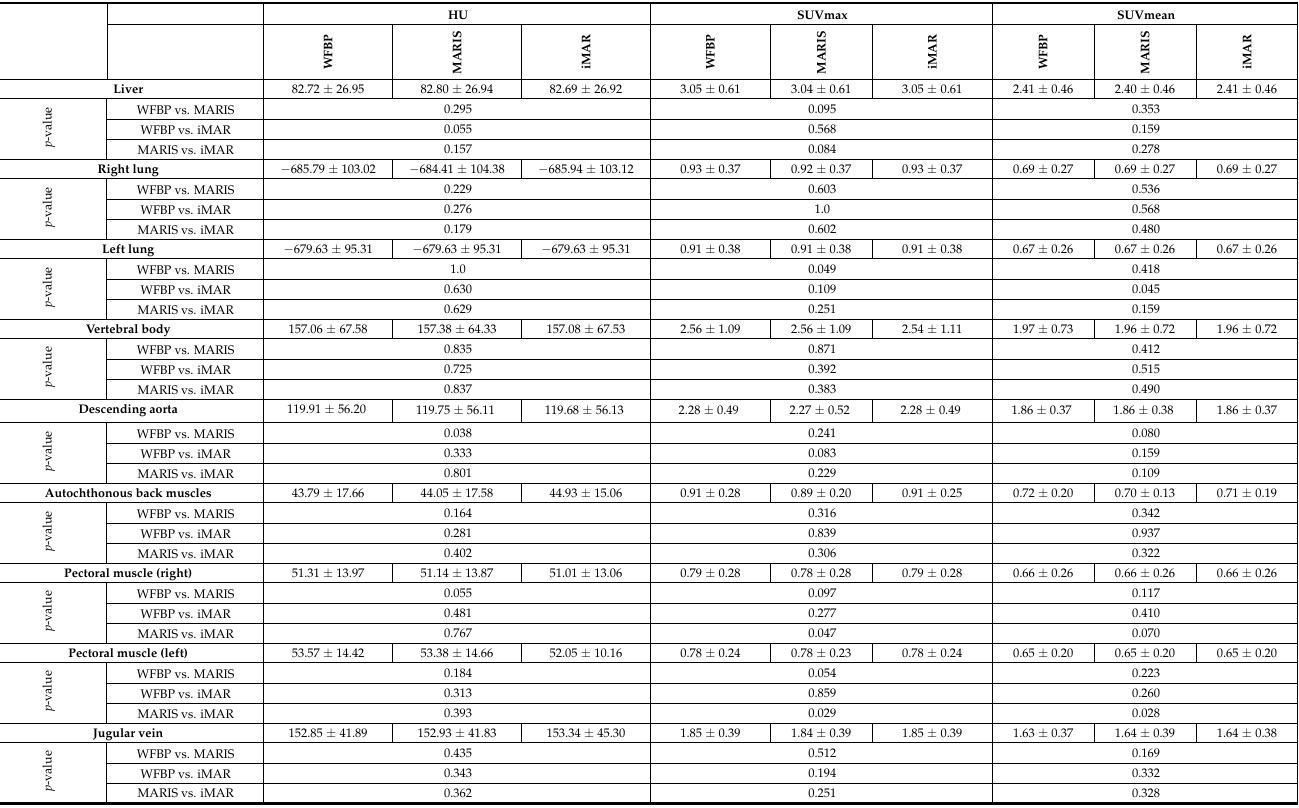
and iMAR, and 119.91 ± 56.20 HU vs. 119.75 ± 56.11 HU vs. 119.68 ± 56.13 HU for the descending aorta. In WFBP, the HU measurements for autochthonous back muscles were 43.79 ± 17.66 HU, whereas measurements for MARIS and iMAR were 44.05 ± 17.58 HU and 44.93 ± 15.06 HU, respectively. For the right and left pectoral muscle, HU measurements in WFBP, MARIS, and iMAR were 51.31 ± 13.97 HU vs. 51.14 ± 13.87 HU vs. 51.01 ± 13.06 HU (right) and 53.57 ± 14.42 HU vs. 53.38 ± 14.66 HU vs. 52.05 ± 10.16 HU (left). For the jugular vein, HU measurements were 152.85 ± 41.89 HU vs. 152.93 ± 41.83 HU vs. 153.34 ± 45.30 HU. Compared to WFBP, the metal artifact reduction algorithms MARIS and iMAR showed no significant impact on HU measurements in all investigated organs (Table 1). Table 1. Values for HU and SUV measurements in different normal organs in WFBP, MARIS, and iMAR reconstruction, and the respective p -values. HU SUVmax